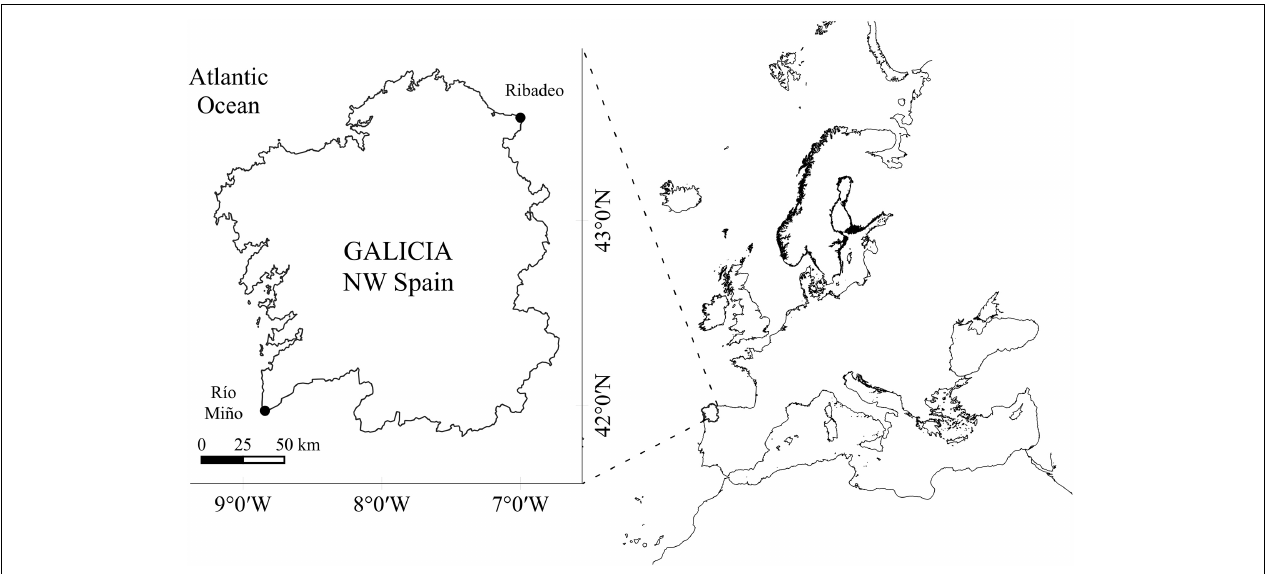
FIGURE 1 | Map of the study area (Galicia, NW